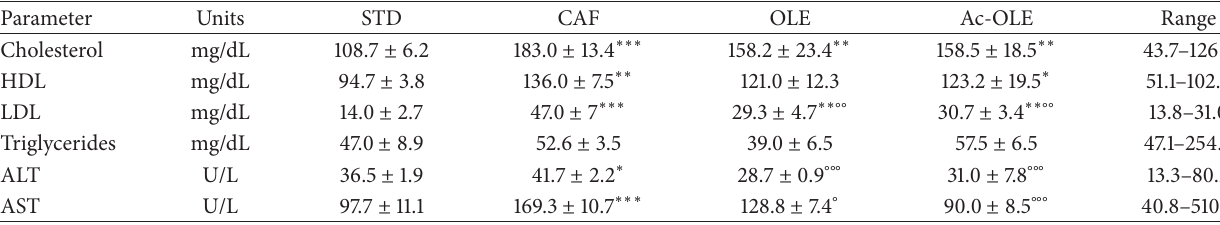
Table 4: Effects of Ole and Ac-Ole on serum parameters.